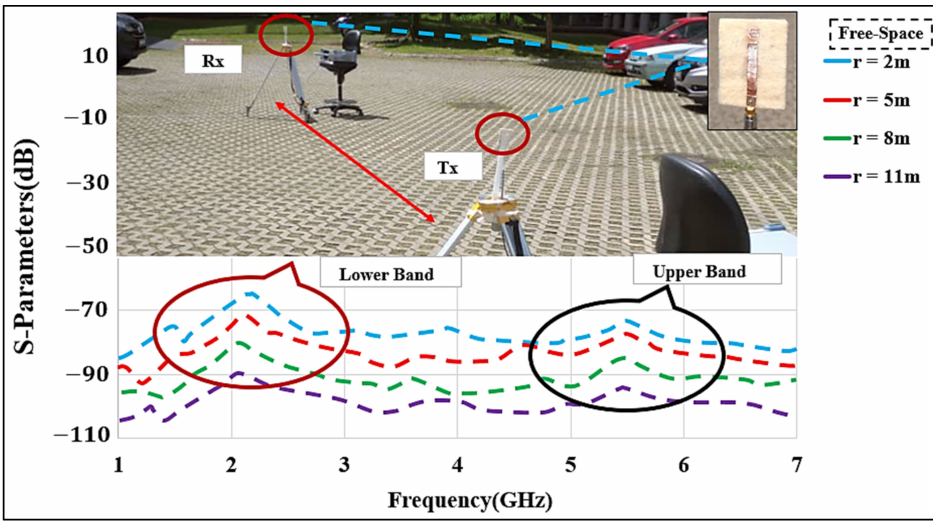
Figure 13. Measured S 21 of the MMAs in free-space at various distances between the Tx and Rx antennas (r: 2 to 11 m).